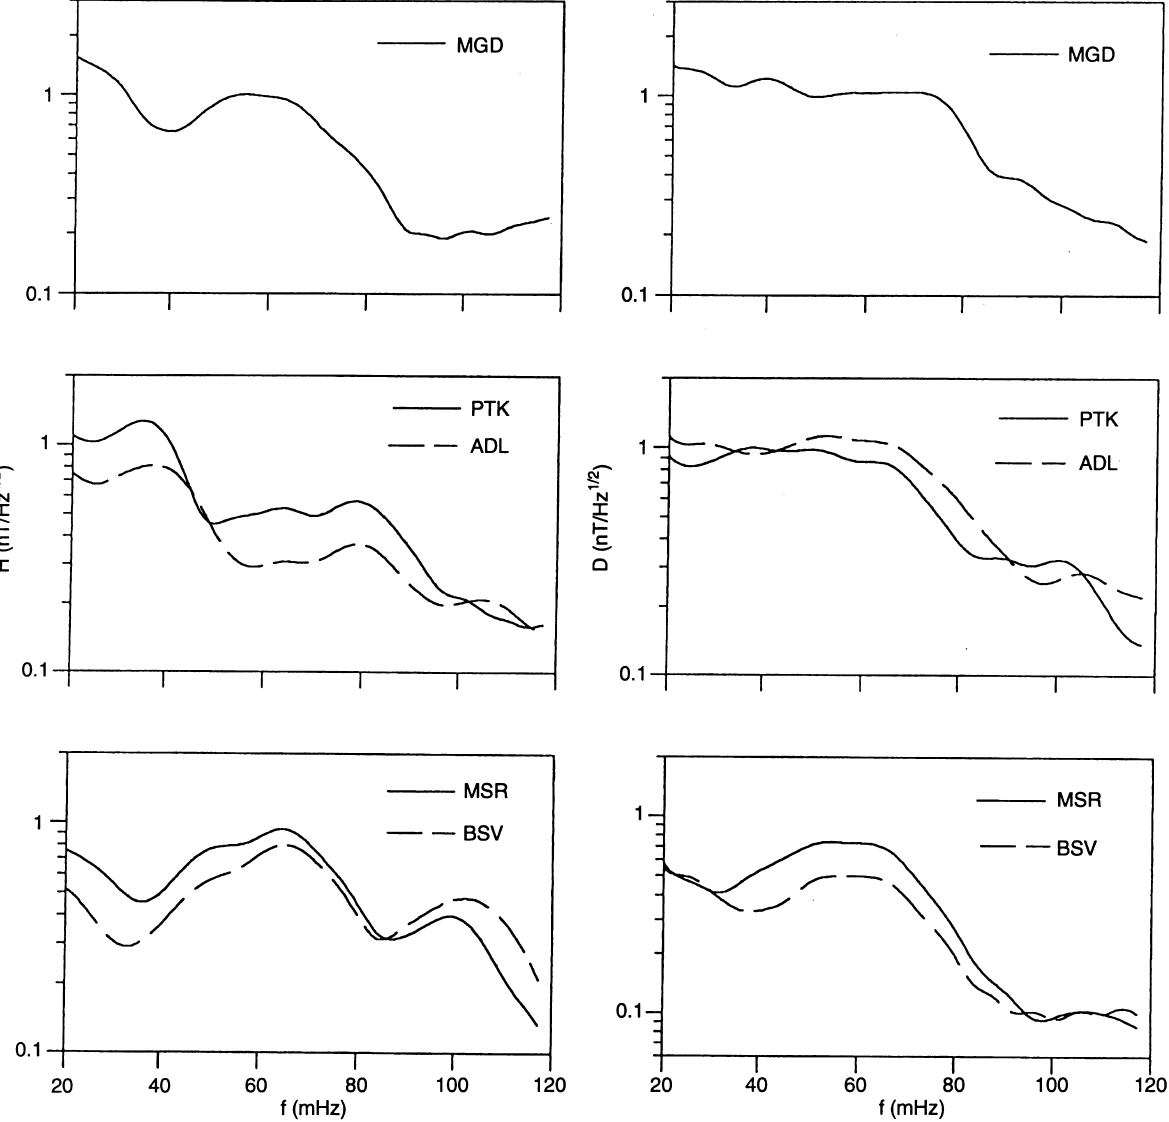
Fig. 7. Amplitude spectra of H (left) and D (right) components of pulsations for the